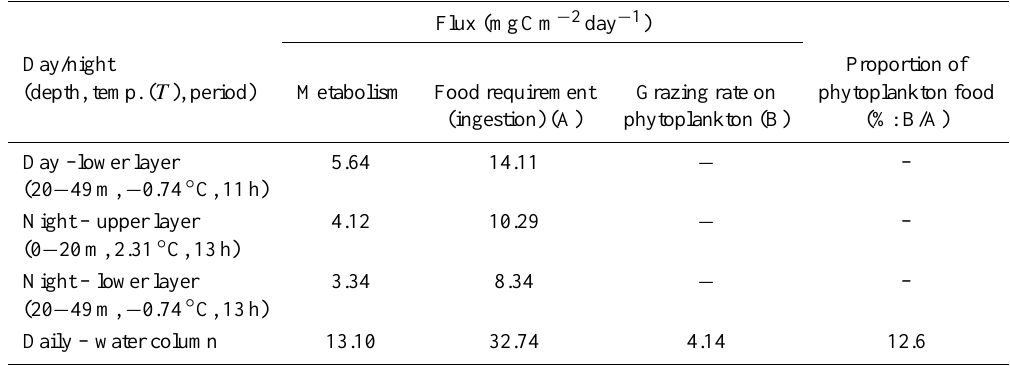
Table 2. Calanus glacialis : comparison of food requirements (ingestion) and grazing rate on phytoplankton and the proportion of phyto- plankton food in the Chukchi Sea from 10 to 25 September 2013. Food requirements were calculated from the metabolism, which was estimated by means of the body mass, temperature (Ikeda et al., 2001), respiratory quotient (Gnaiger, 1983) and individual carbon budget (Ikeda and Motoda, 1978). For details on the values used in this calculation, see the